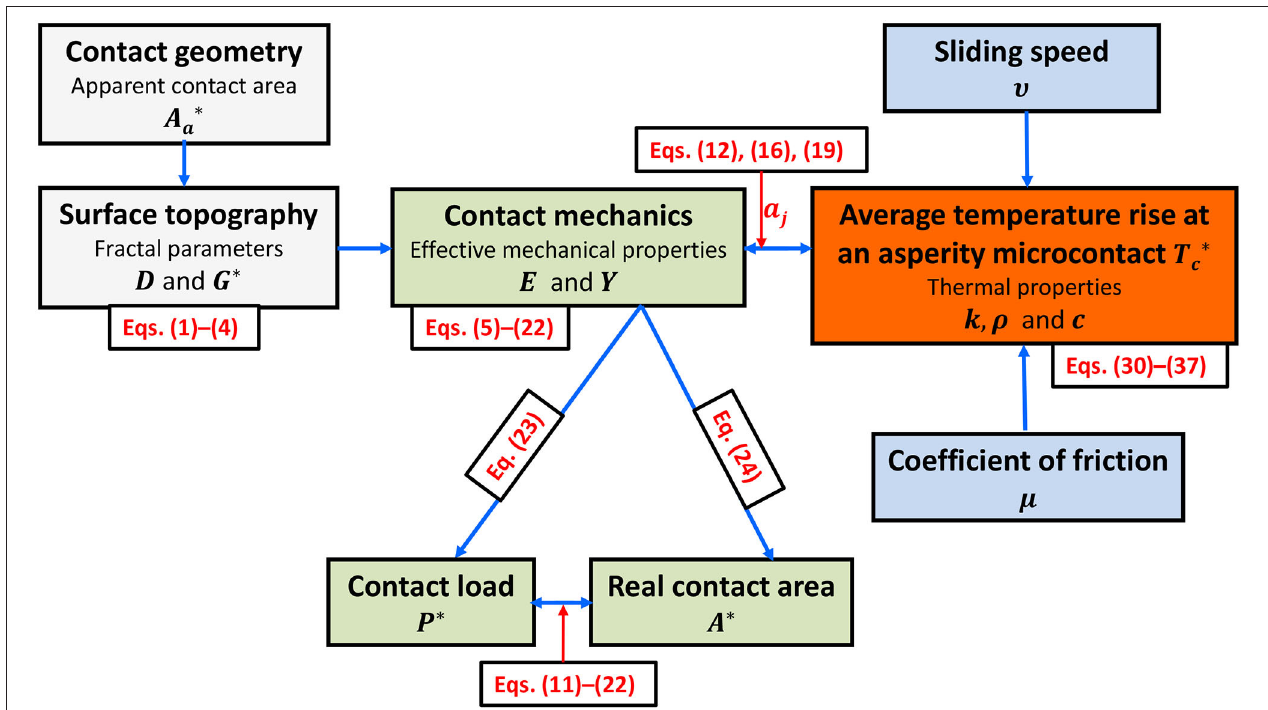
FIGURE 9 | Thermomechanics flow chart for rough (fractal) contact interfaces. Dimensionless parameters are indicated by an